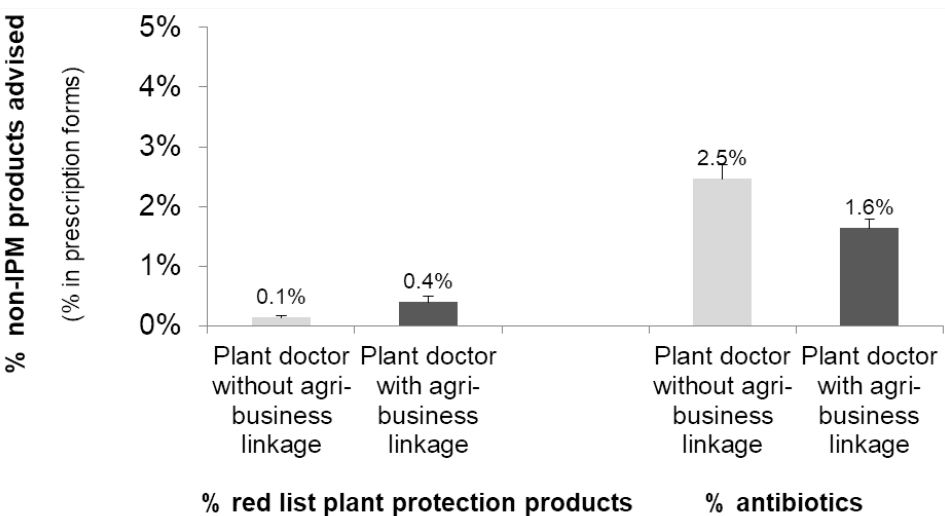
Figure 2. Non-IPM compatible plant protection products recommended to growers by non-business and agri-input-business-linked agricultural extension workers (here plant doctors) in plant clinics in Beijing municipality of China between 2014 and 2016 (% red list products or % antibiotics as per issued prescriptions form ± SEM). Red list products as per Stockholm Convention, Rotterdam Convention, Montreal Protocol, WHO toxicity class 1a, 1b, [25,26]. Dark grey bars = agri-input business-linked, Light grey bars = without agri-input business linkage, only active plant clinics are shown with more than 10 issued prescription forms per year (different letters on bars indicate differences according independent samples t-test with session and plant doctor nested data at p < 0.05).